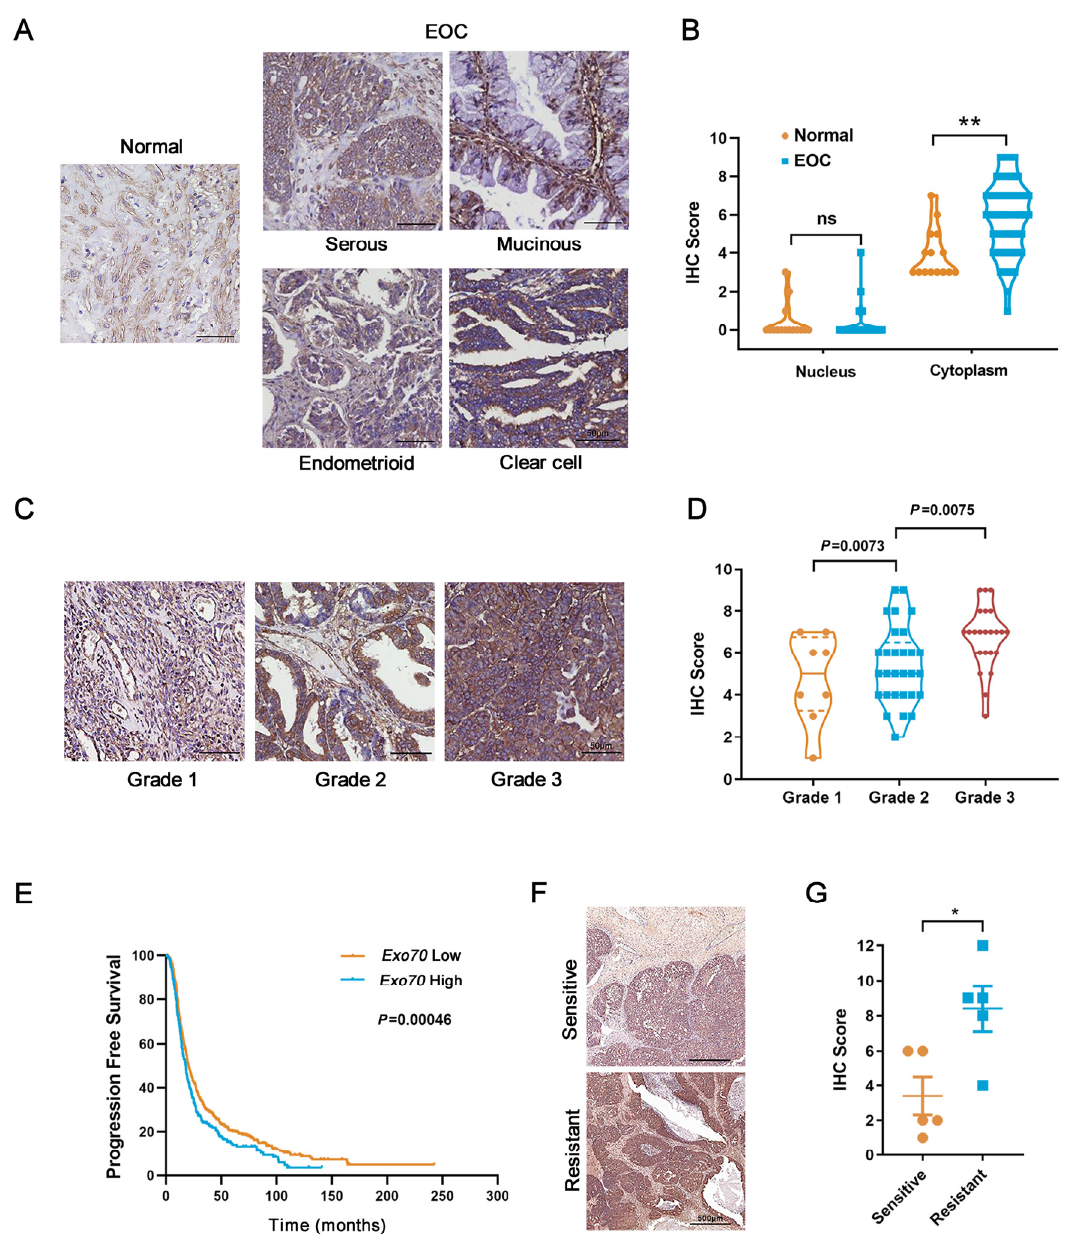
Figure 1. Exo70 is overexpressed in epithelial ovarian cancer (EOC) patients’ tissues and associated with shortened progression-free survival in platinum-treated EOC patients. ( A ) Representative photographs of immunohistochemistry (IHC) for Exo70 in normal ovarian and EOC tissues. Scale bar, 50 µ m. ( B ) Statistics of Exo70 expression level in normal ovarian and EOC tissues. ** p < 0.01. ( C ) Representative photographs of immunohistochemistry for Exo70 in different pathological grades of EOC tissues. Scale bar, 50 µ m. ( D ) Statistics of Exo70 expression level in different pathological grades of EOC tissues. Bonferroni correction was used to adjust p values. ( E ) Progression-free survival curve in platinum treated EOC patients of high versus low Exo70 expression. Data were generated online by using the Kaplan-Meier Plotter database based on microarray gene expression data from patients for whom PFS data are available (www.kmplot.com/ovarian (accessed on 3 February 2019)). ( F ) IHC staining of Exo70 in samples from platinum-sensitive (upper panel) and platinum- resistant (lower panel) EOC patients. Scale bar, 500 µ m. ( G ) Statistics of Exo70 expression level in different pathological grades of EOC tissues. * p <